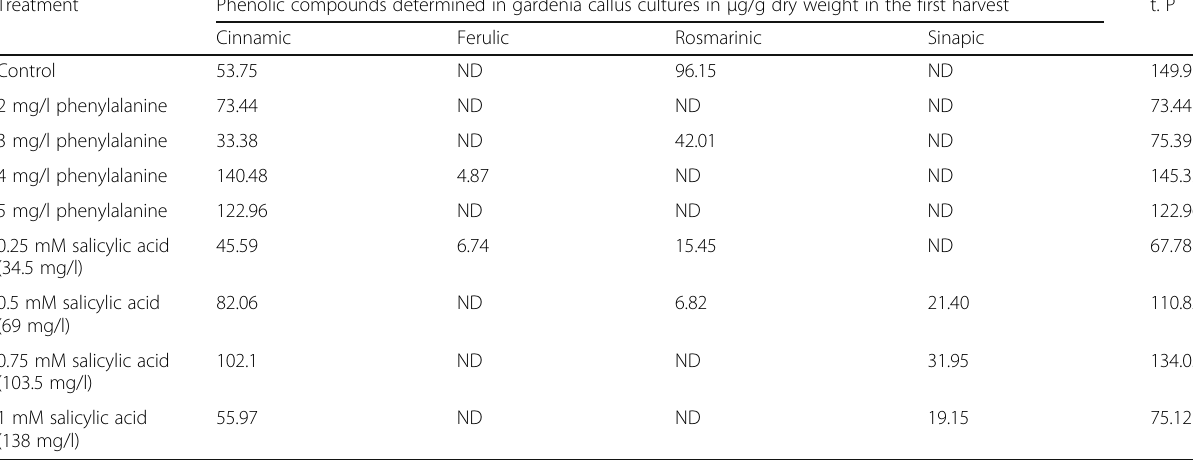
Table 5 Phenolic compound determination in gardenia calli cultures cultured on MS media contained different concentrations of phenyl alanine or salicylic acid during the first harvested period of culturing by HPLC